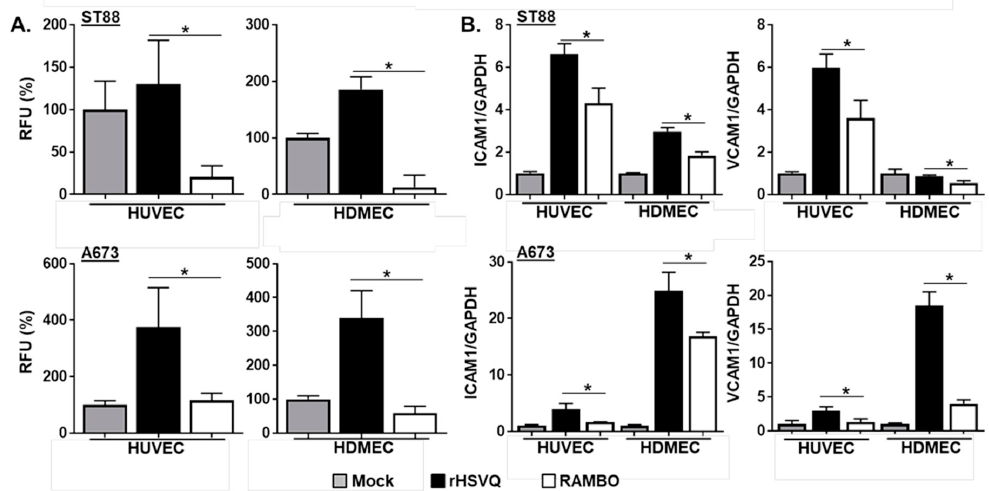
Figure 3. RAMBO decreases endothelial cell activation. ( A ) RAMBO decreases endothelial cell activation. HUVEC or HDMEC cells were plated on 96-well plates and treated with conditioned media (CM) collected from mock-, rHSVQ-, or RAMBO-infected sarcoma cells. Eight hours post CM treatment, cells were treated with LeukoTracker TM -labeled peripheral blood mononuclear cells (PBMCs) and allowed to adhere to endothelial cells. After 1 h incubation, unadherent PBMCs were washed off and adherent cells were lysed and quantified as instruction. Data is represented as relative fluorescence unit (RFU). ( B ) RAMBO decreases ICAM1 and VCAM1 gene expression. HUVEC and HDMEC cells were plated on 12-well plates. Six hours later, sarcoma cell lines were infected with 0.2 MOI of HSVQ and RAMBO for 30 min in a suspension condition. HUVEC and HDMC cells were overlaid with infected sarcoma cells and cultured for 24 h. Q-PCR analysis was conducted to examine for changes in gene expression of ICAM1 and VCAM1 between rHSVQ- and RAMBO-infected cells cocultured with endothelial cells. Data presented are fold changes in gene expression ± SD relative to GAPDH. * p < 0.05.